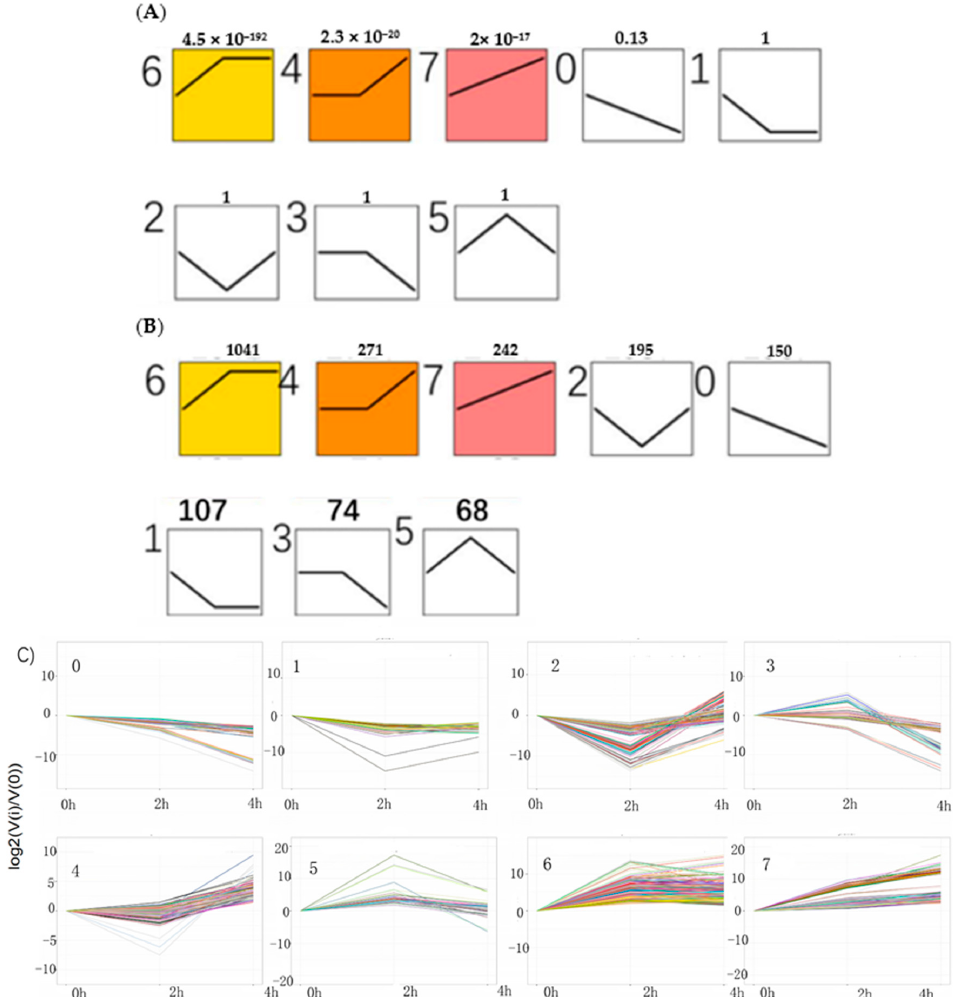
Figure 8. Expression trends of the total di ff erentially expressed genes (DEGs). The profile’s number is placed on the upper left corner of each graph. ( A ) P-value of each profile from low to high. ( B ) Gene number of each profile from high to low. ( C ) Genes with the same expression trends are placed in the same